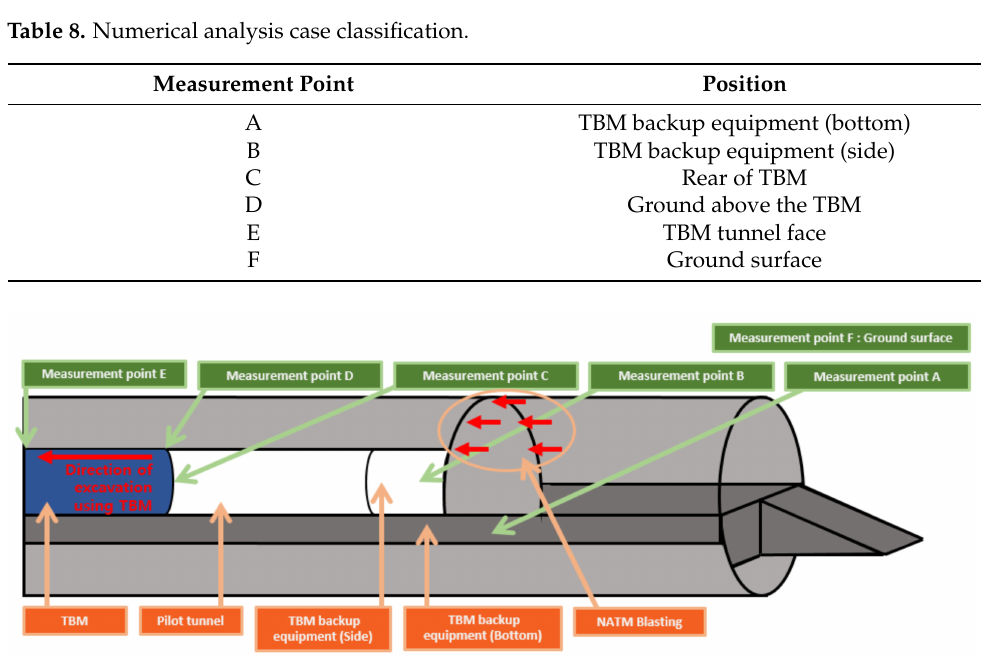
Figure 4. Vibration velocity measurement